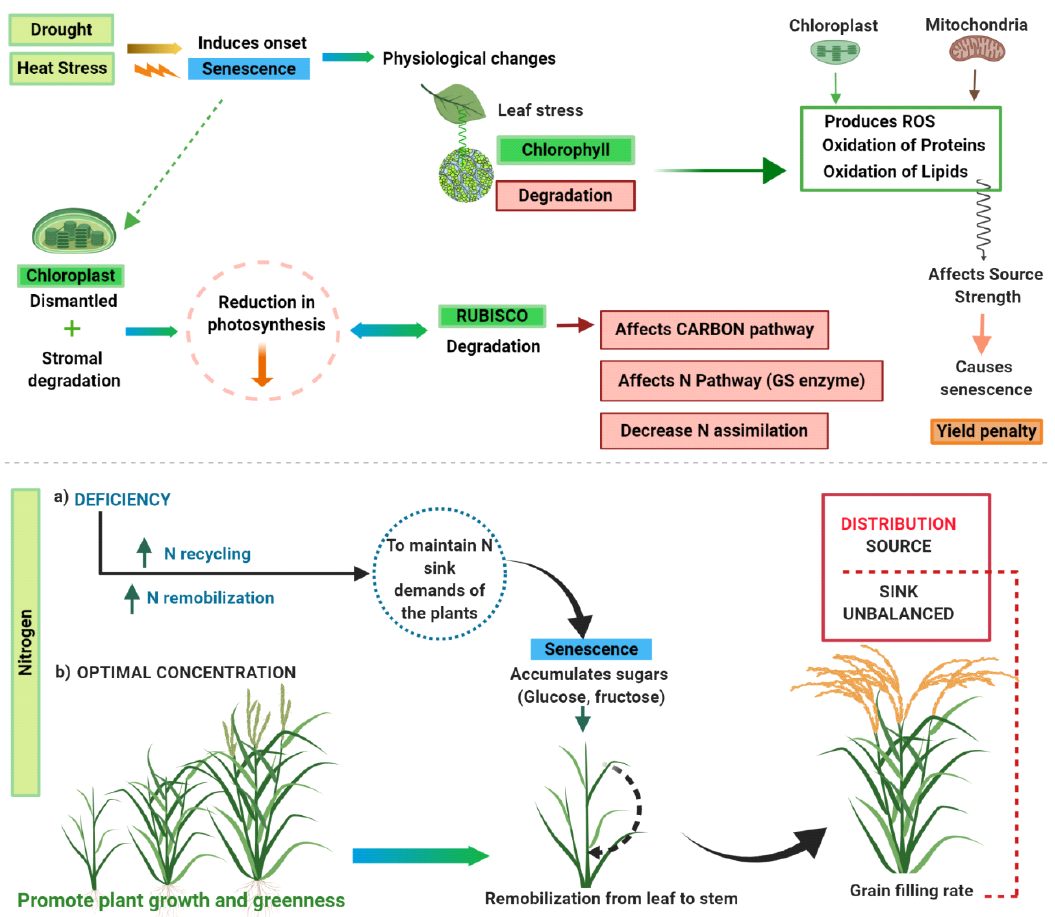
Figure 1. Schematic diagram showing physiological changes caused by external factors that leads to senescence in plants.